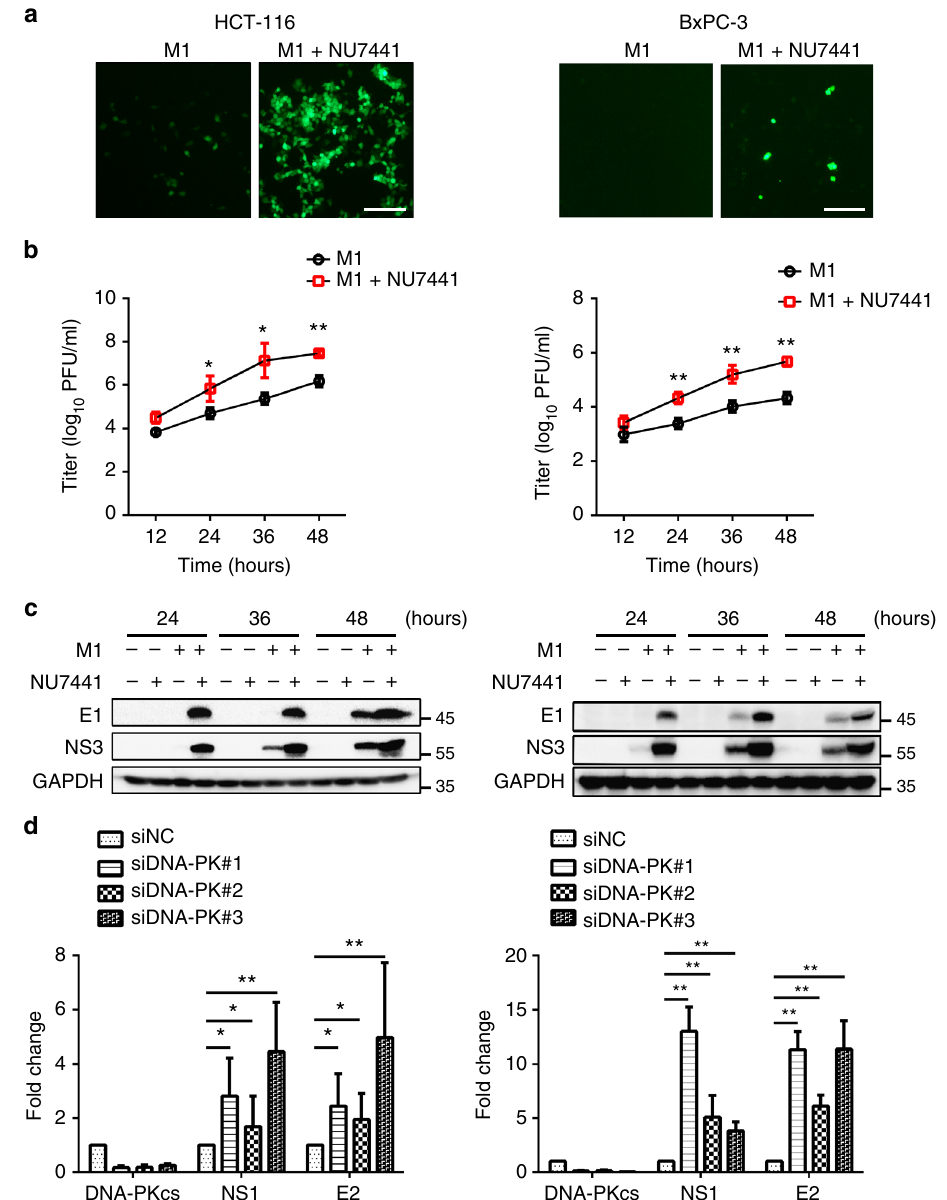
Fig. 3 DNA-PK inhibition increases the replication of M1 virus in refractory tumour cells. a HCT-116 or BxPC-3 cells were infected with M1-GFP (MOI = 1) in the presence or absence of NU7441 (1 μ M) for 24 h, after which the phase-contrast and fl uorescence microscopy images were captured. Scale bar: 50 μ m. b HCT-116 or BxPC-3 cells were infected with M1-GFP (MOI = 1) in the presence or absence of NU7441 (1 μ M). Single-step growth analyses were conducted. n = 4. c HCT-116 or BxPC-3 cells infected with M1-GFP (MOI = 1) in the presence or absence of NU7441 (1 μ M), viral structural protein E1 and the non-structural protein NS3 were analyzed by western blot after treatment. d HCT-116 or BxPC-3 cells were treated with siRNA targeting DNA-PKcs (48 h), followed by M1 virus infection (MOI = 1), and then processed for qRT-PCR to measure the viral gene E2 and NS1. n = 3. Data represent the mean ± SD in b , d . * P < 0.05; ** P < 0.01; *** P < 0.001 by two-way ANOVA for b or one-way ANOVA for